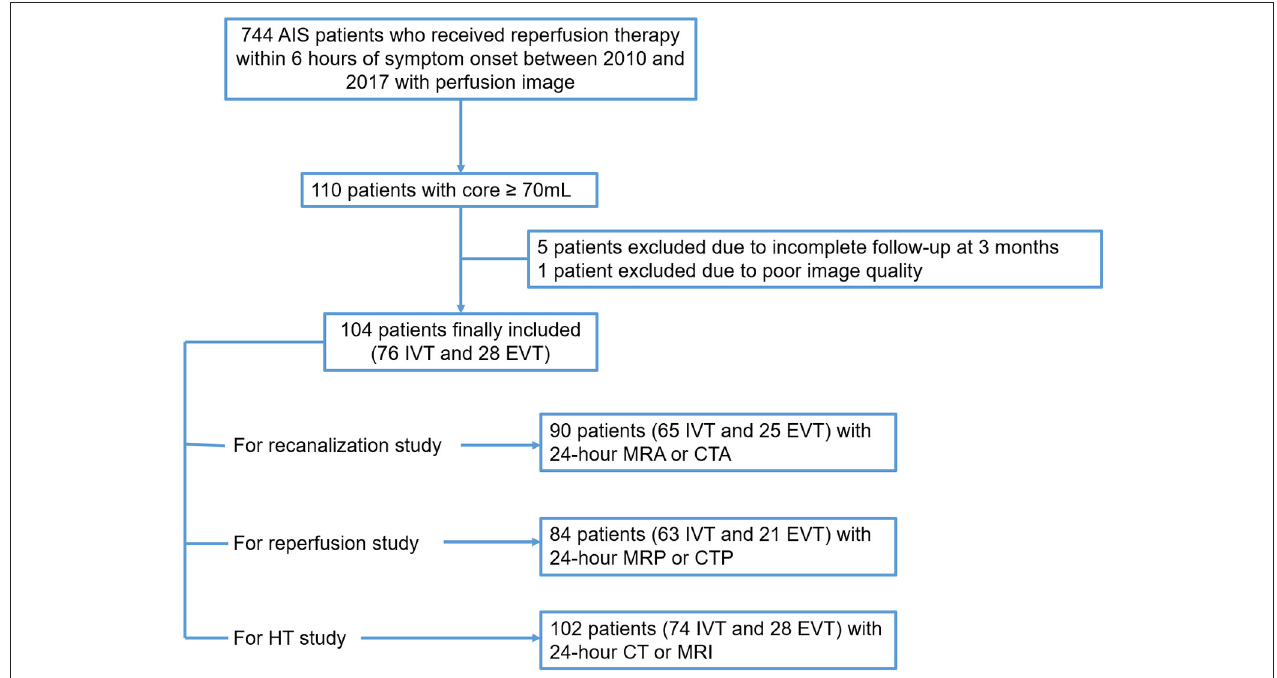
FIGURE 1 | Patient flow chart. AIS, acute ischemic stroke; IVT, intravenous thrombolysis; EVT, endovascular treatment; HT, hemorrhage transformation.